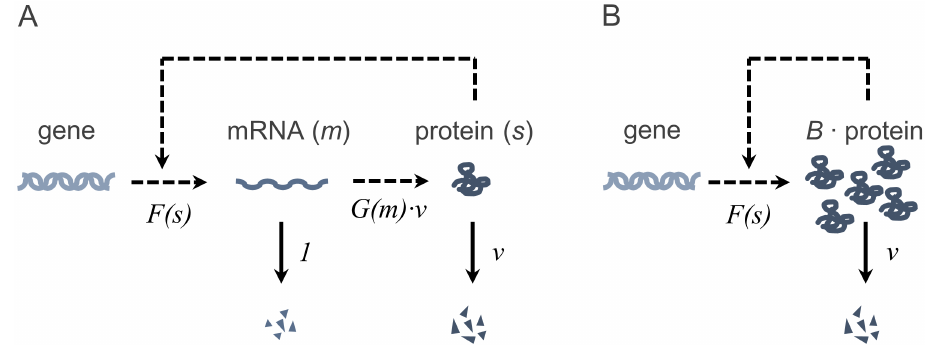
Fig 1. Reaction schemes of autoregulatory expression. (A): Full model including the mRNA and protein level. (B): Reduced model where the mRNA level is omitted and protein expression occurs in translational bursts of random size B . Solid lines indicate conversion reactions, while dashed lines describe